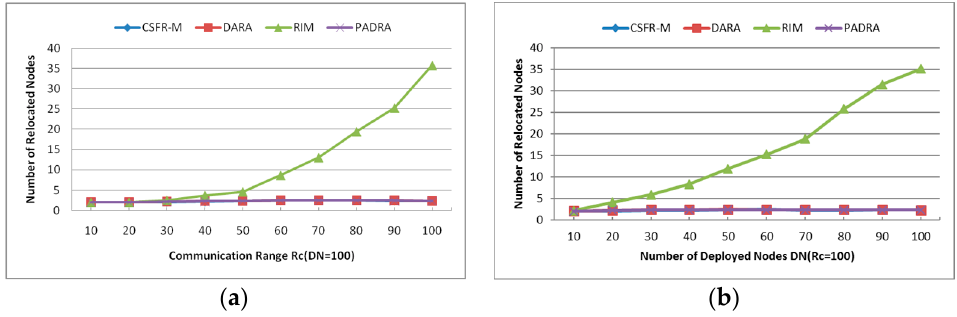
Figure 12. ( a ) RN with different (cid:1844) (cid:3030) ; and ( b ) RN with different DN.